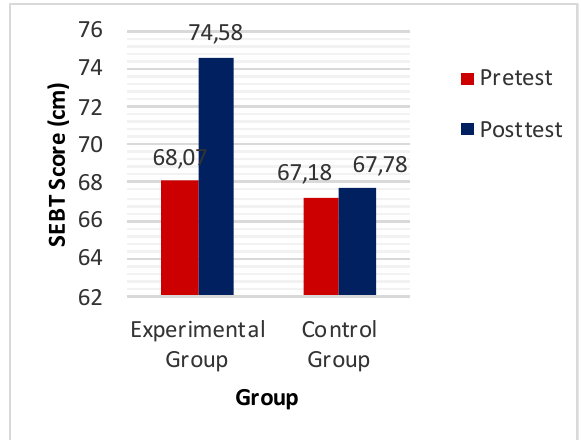
Figure 1. The Comparison Scores of Pretest and Posttest for SEBT between and within experimental group and control group after Six Weeks of CoBAgi Training Table 3. The Comparison of Pretest and Posttest Between and Within Control Group and Experimental Group in SEBT Score after Six Weeks with CoBAgi Training